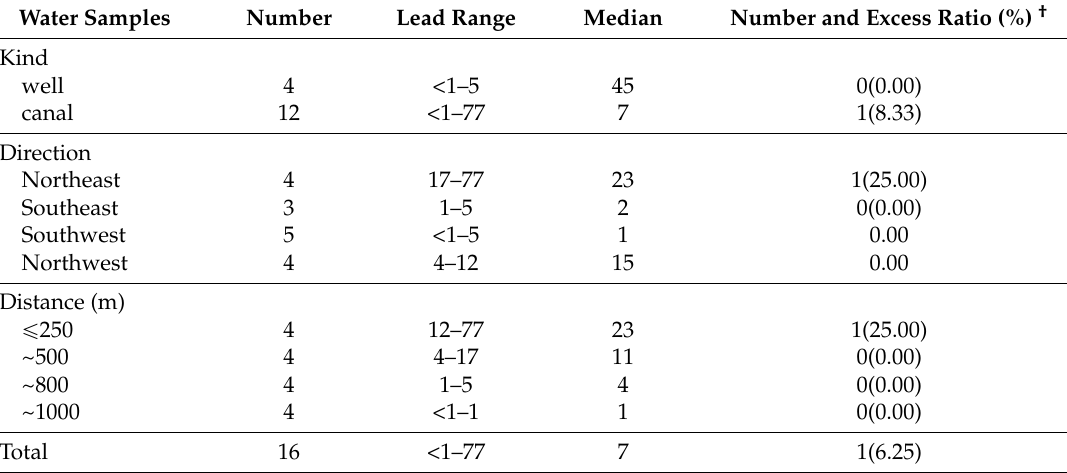
Table 5. The result of water samples ( µ g/L).